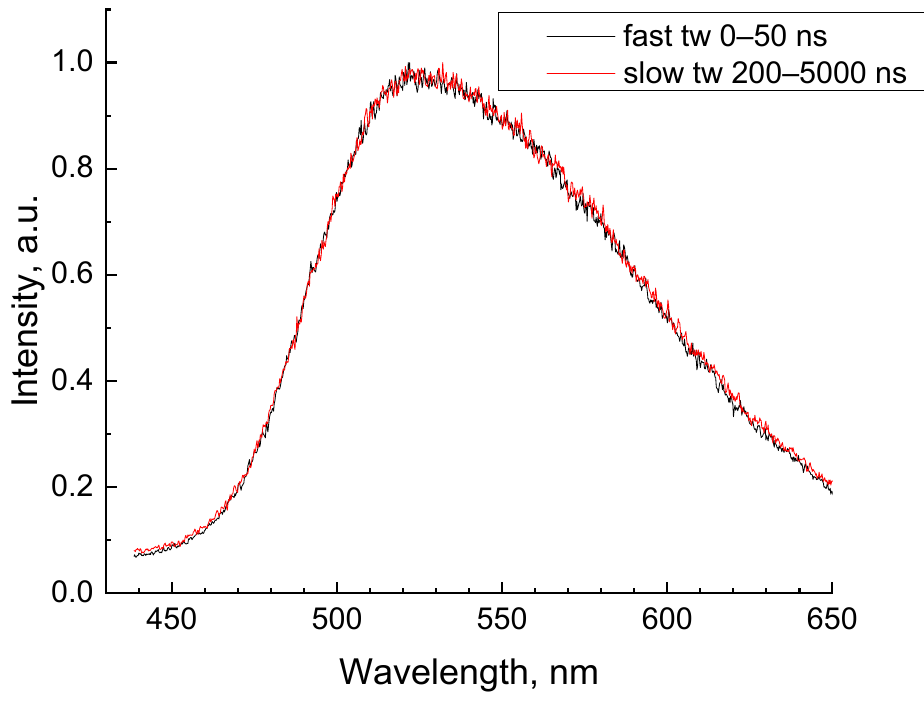
Figure 3. Luminescence spectra of GAGG:Ce measured at E ex = 6.2 eV in fast (0–50 ns) and slow (200–5000 ns) time windows.